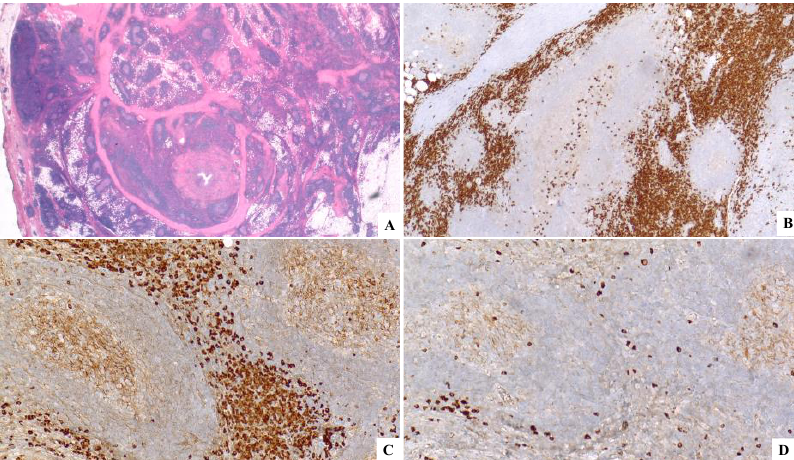
Figure 8. ( A ) H&E original magnification 2 × displaying a lymphoproliferative lesion in the back- ground of septal, a storiform fibrosis. ( B ) CD138+. ( C , D ) A Kappa light chain restriction.